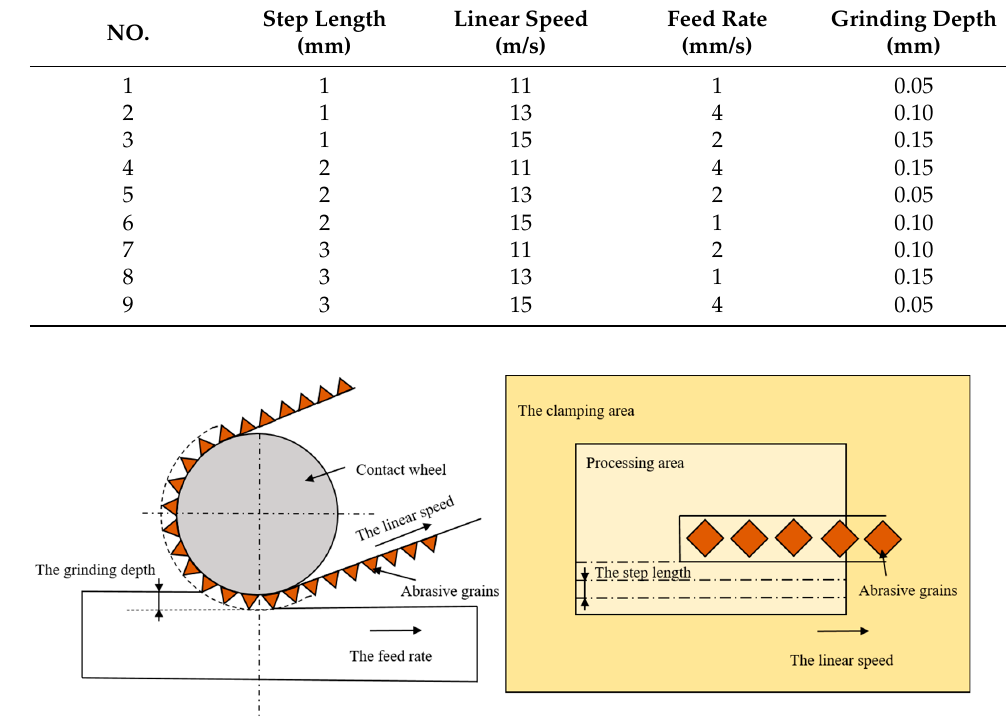
Figure 2. Meaning of grinding parameters.